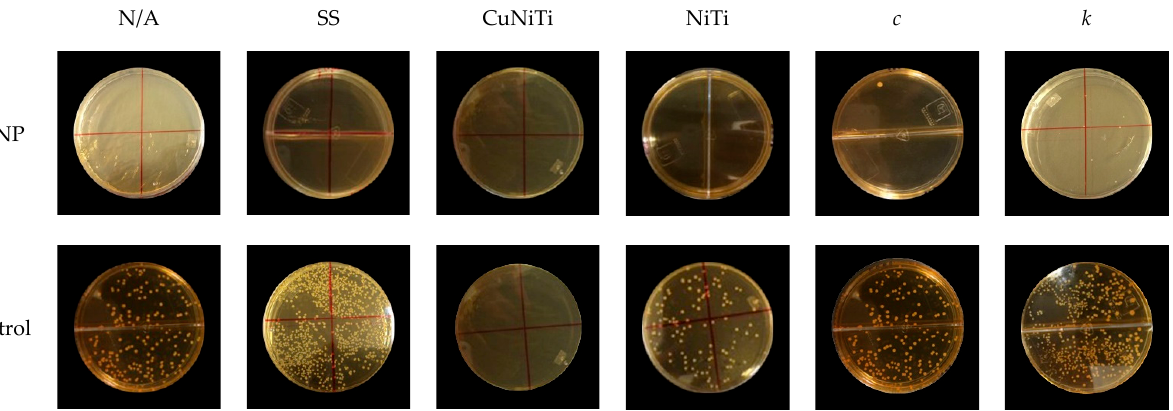
Figure 4. Representative agar plates of the anti-adherence activity of AgNP according to orthodontic wires and S. mutans serotypes. AgNP = silver nanoparticles; N/A = no archwire; SS = stainless steel; CuNiTi = copper/nickel/titanium; and NiTi= nickel/titanium.